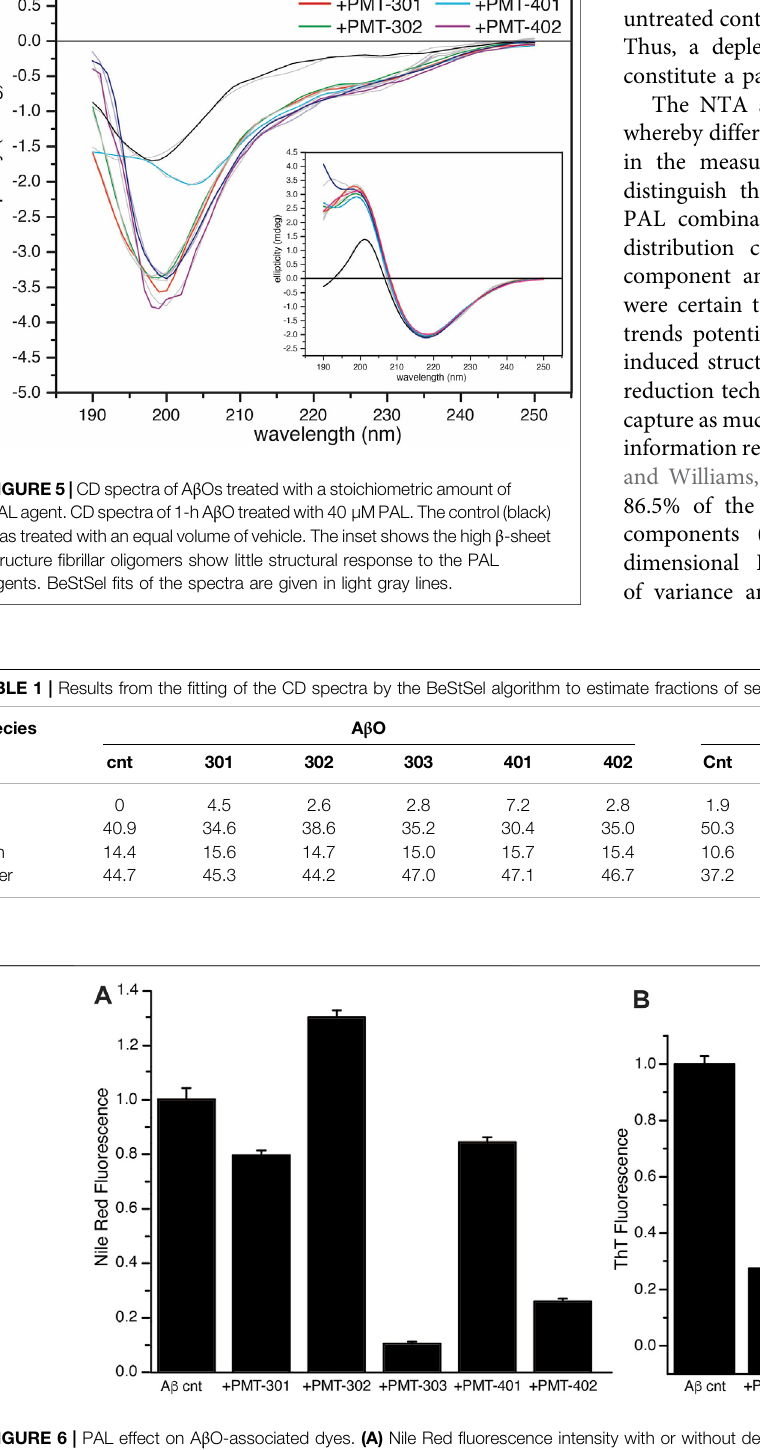
Frontiers in Chemistry |